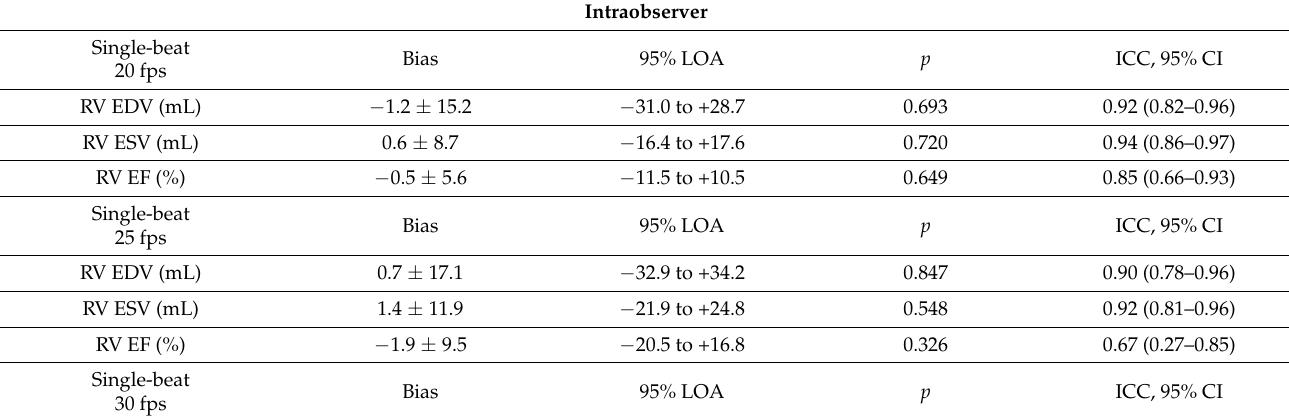
Table A2. Results of the 3DE reproducibility study in patients (group 2). Intra- and interobserver analysis is evaluated using Bland-Altman analysis (Bias ± SD and 95% upper LOA to 95% lower LOA), paired Student t -test ( p ) and Intraclass correlation coefficient